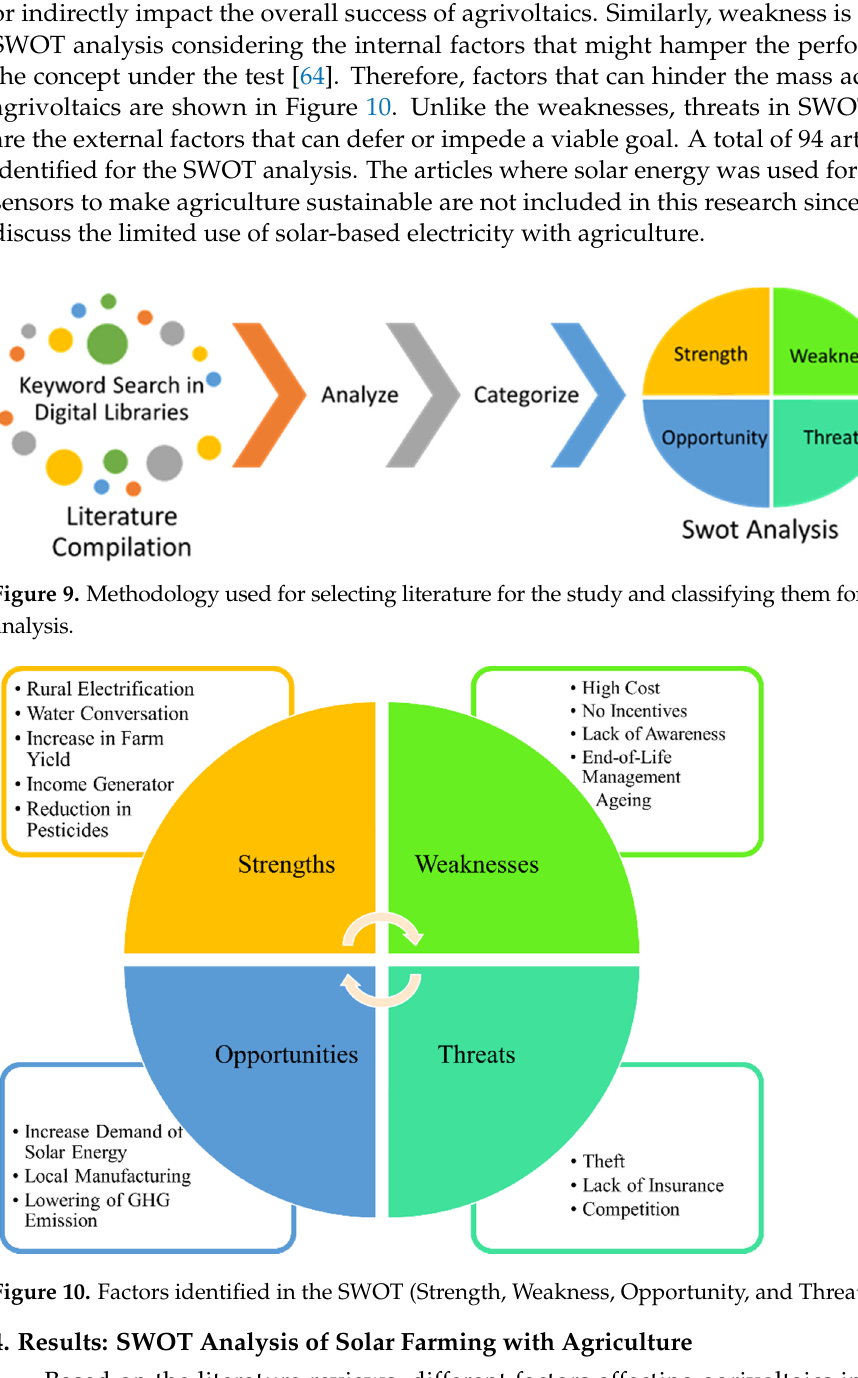
Figure 8. Solar agriculture farm where solar panels are co-located with crops.